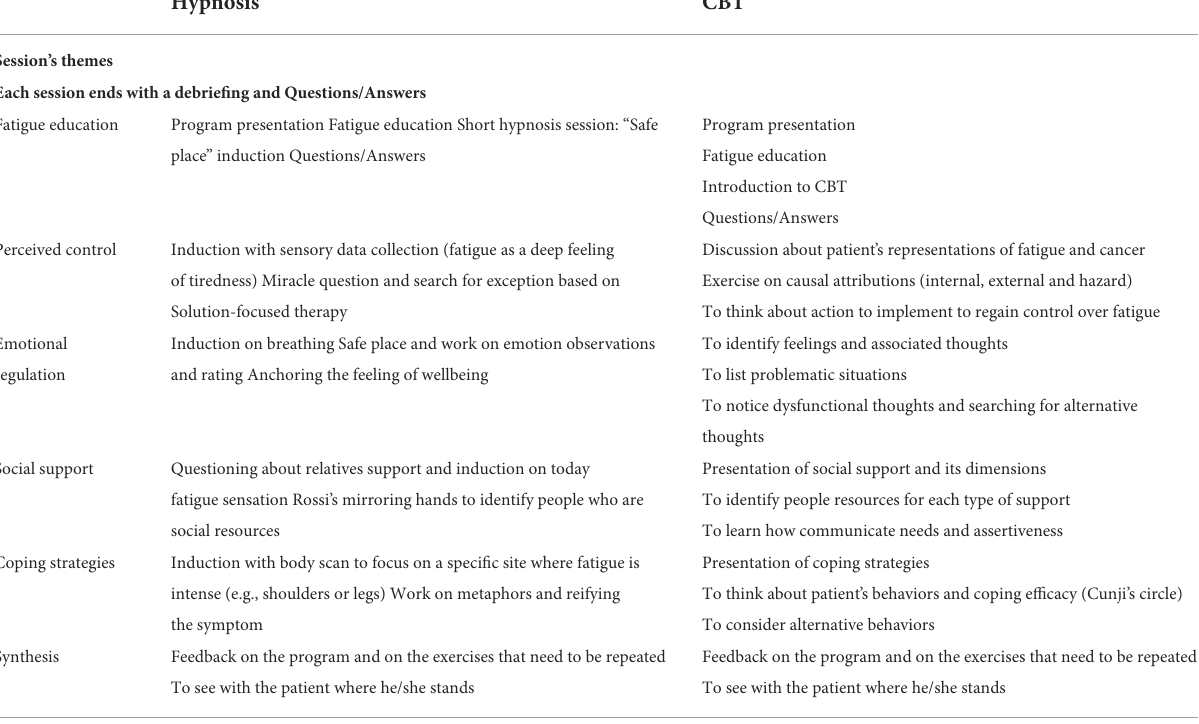
TABLE 1 Description 1 of the sessions for both